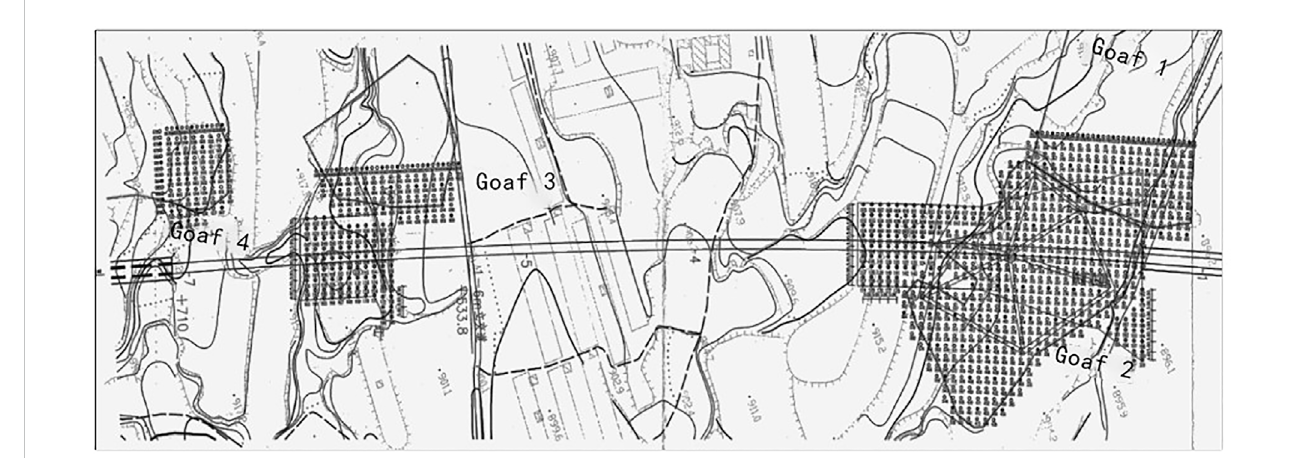
FIGURE 11 Location distribution of grouting holes in the goaf foundation of the Taiyuan – Jiaozuo high-speed